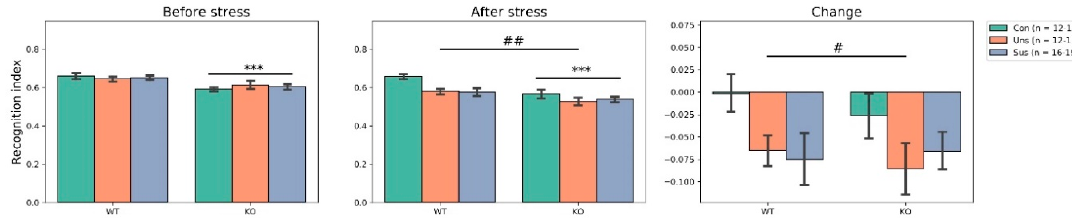
Figure 3. E ff ect of social defeat on the recognition index (RI) of the novel object recognition test